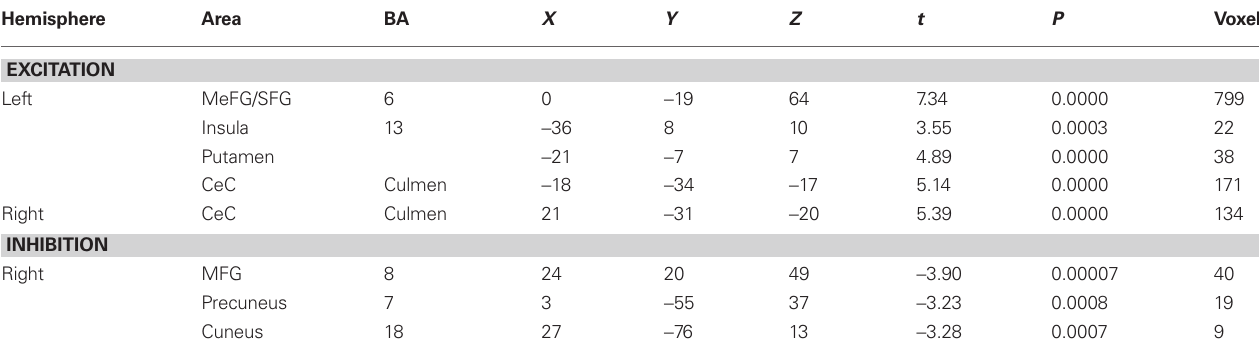
Table 4 | Talairach coordinates, t - and P -values, and voxel numbers of significant regions of interest resulting from conjunction analysis for imagination of backward and forward walking relative to baseline (standing still) (cf. Figure 2, lower panel). Hemisphere